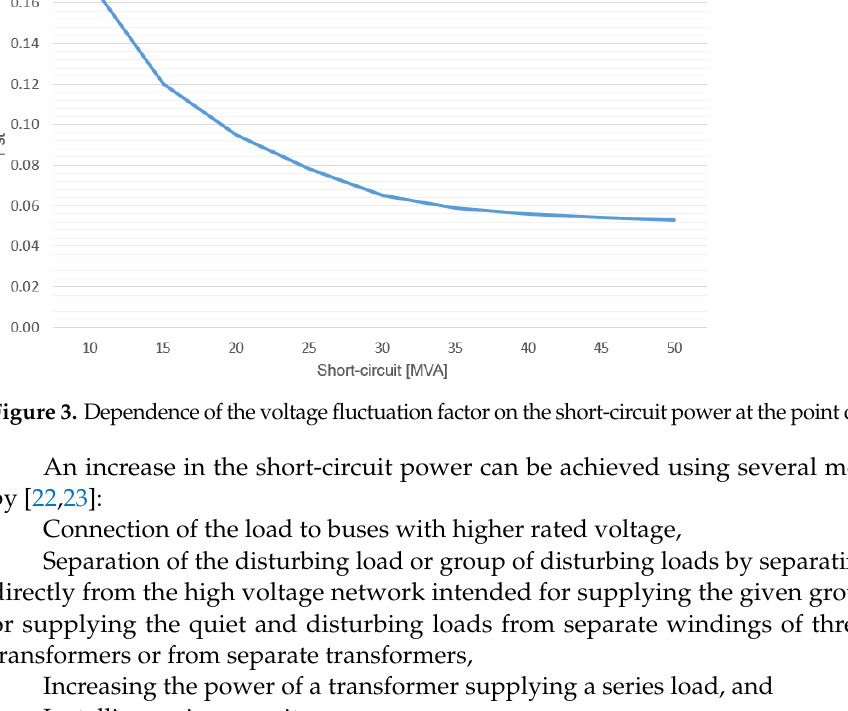
Figure 2. Changes in rms voltage at the terminals of the hydroelectric power plant generator [18].